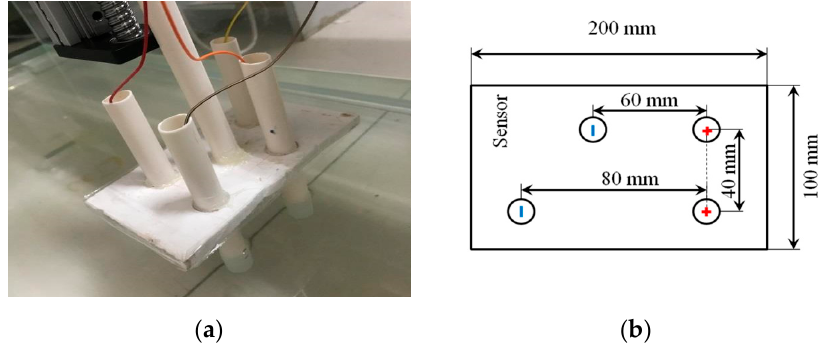
Figure 1. ( a ) The picture of the bionic sensor and ( b ) the structure of the bionic